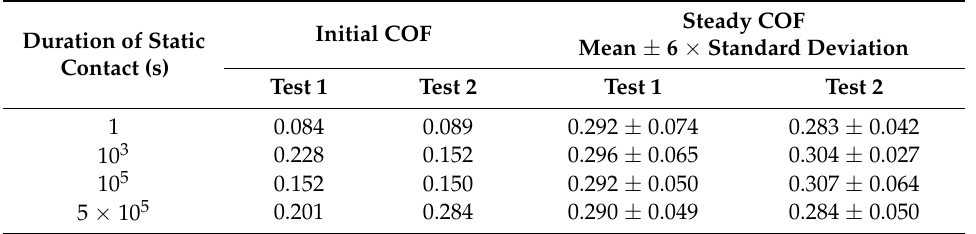
Figure 6. Friction coefficient evolutions of electro-deposited coatings against AISI52100 balls after various durations of static contact. Table 2. The kinetic friction coefficient (COF) between an electro-deposited coating and an AISI52100 ball.